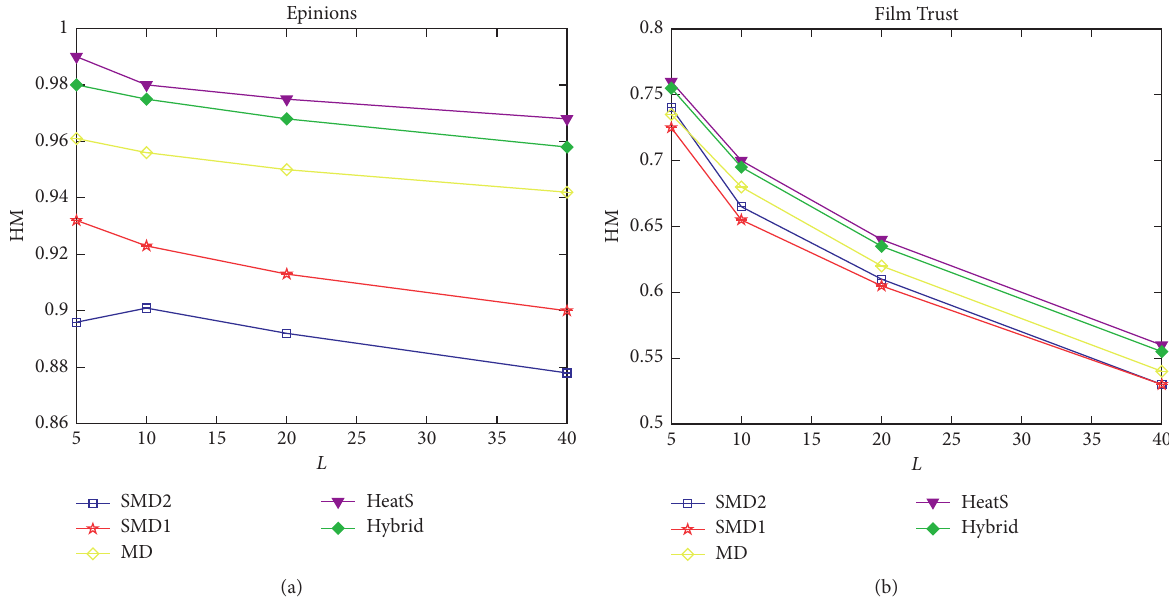
Figure 7: The diversity of various algorithms on two datasets, (a) Epinions dataset. (b) FilmTrust